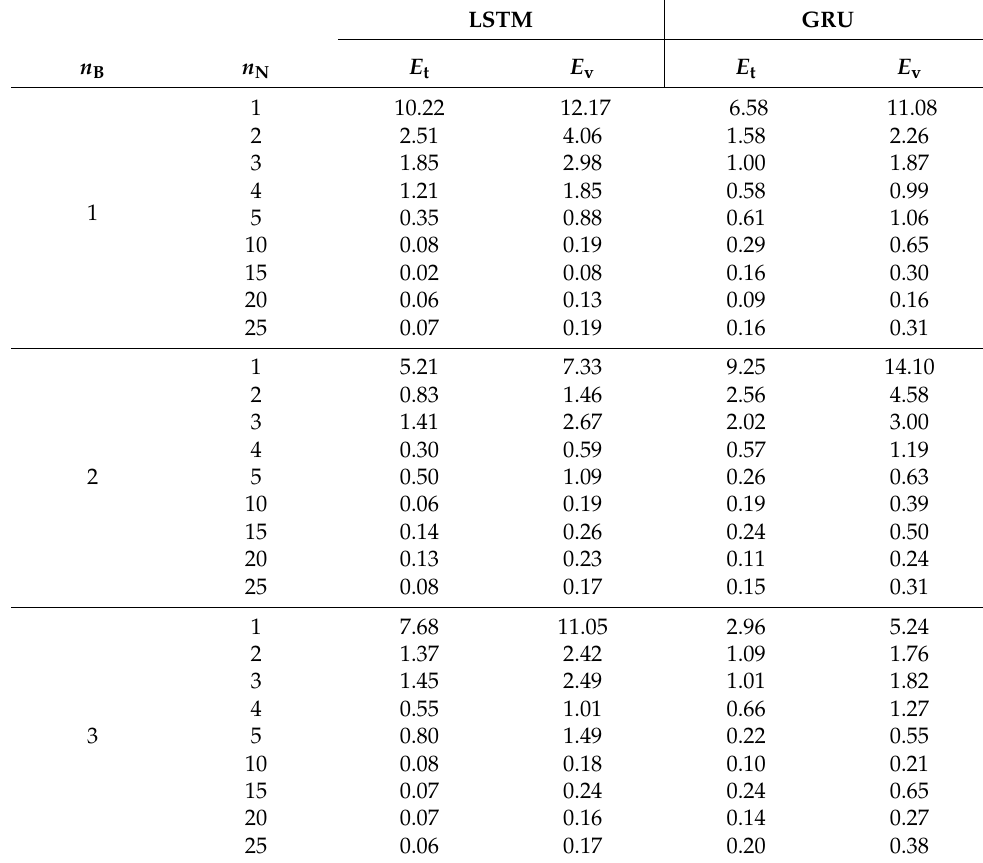
Table 1. The polymerisation reactor: comparison of selected LSTM and GRU networks without the